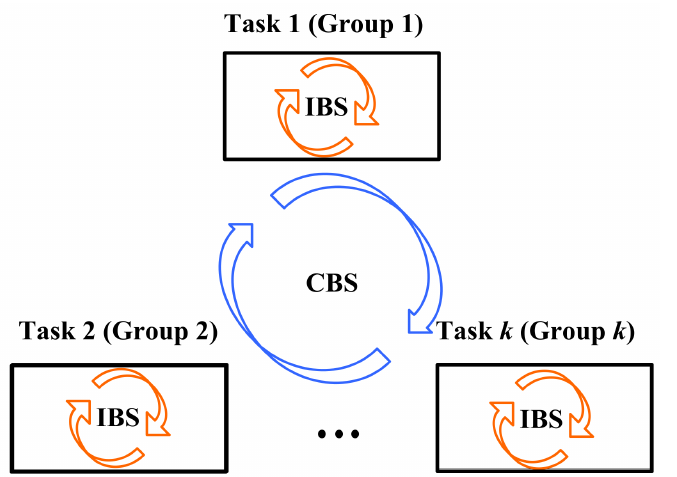
Figure 11. An illustration of the brain storm multi-task problems solver (BSMTPS) framework